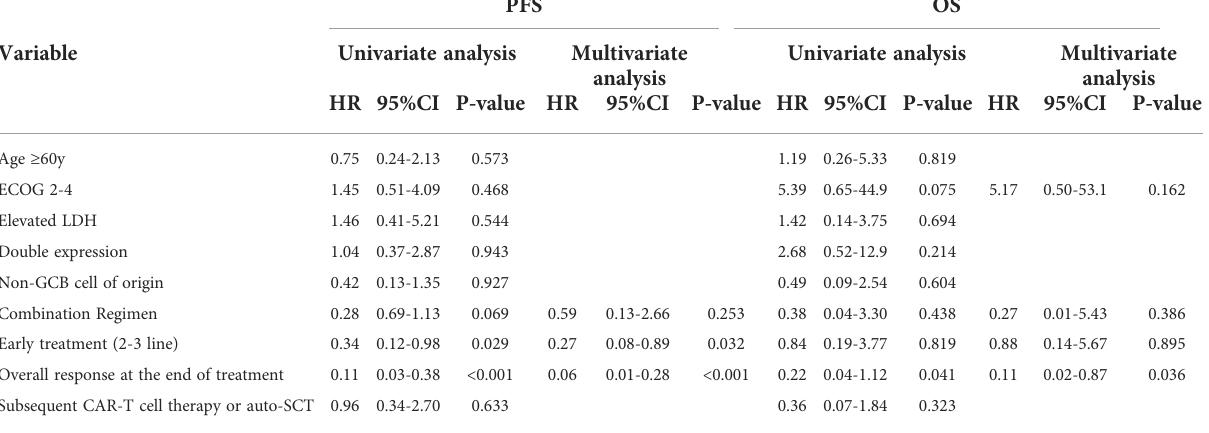
TABLE 2 Univariate and multivariate analyses of overall and progression-free